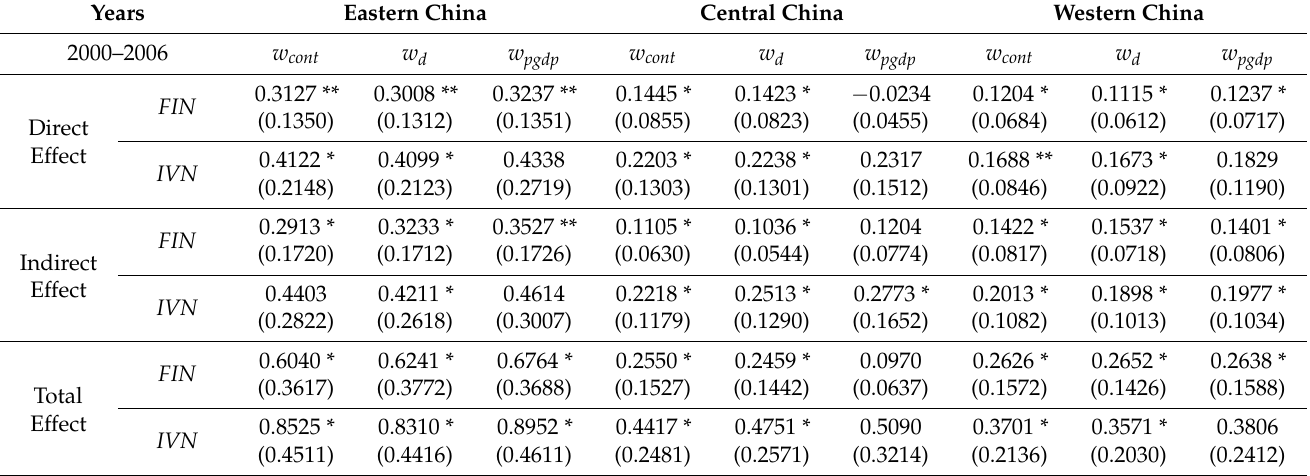
Table 6. Estimation results of time segments in different